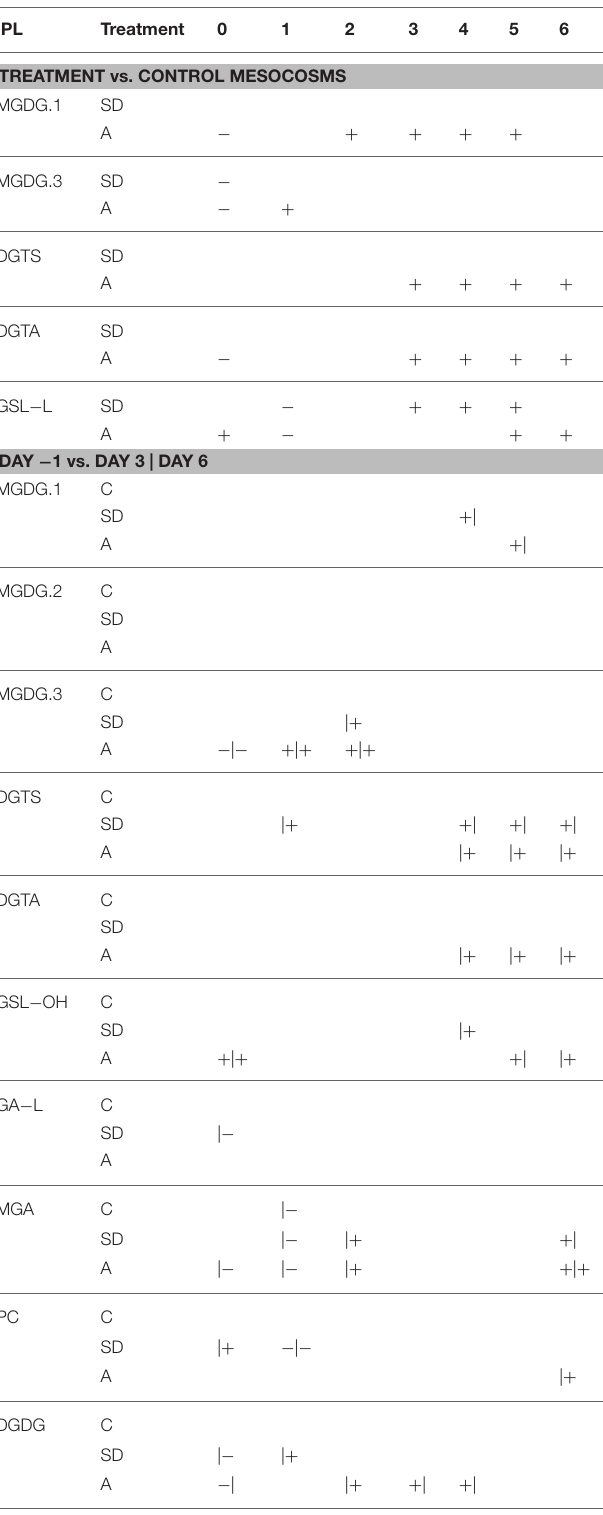
TABLE 3 | Significant increases ( + ) or decreases ( − ) in the relative abundance distribution of unsaturations in the alkyl chains of IPLs.